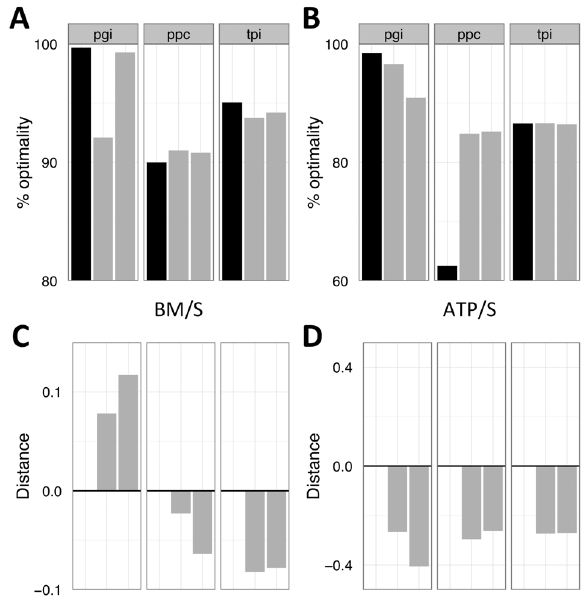
Figure 5. Measures of optimality and predictability after adaptation of gene knockouts on glucose for , 600–800 generations. A,B) The % optimality of the ancestor (black) and evolved isolates (grey); C,D) distance to optimal flux distribution for FBA-predictions based upon BM/S (A,C) or ATP/S (B,D).